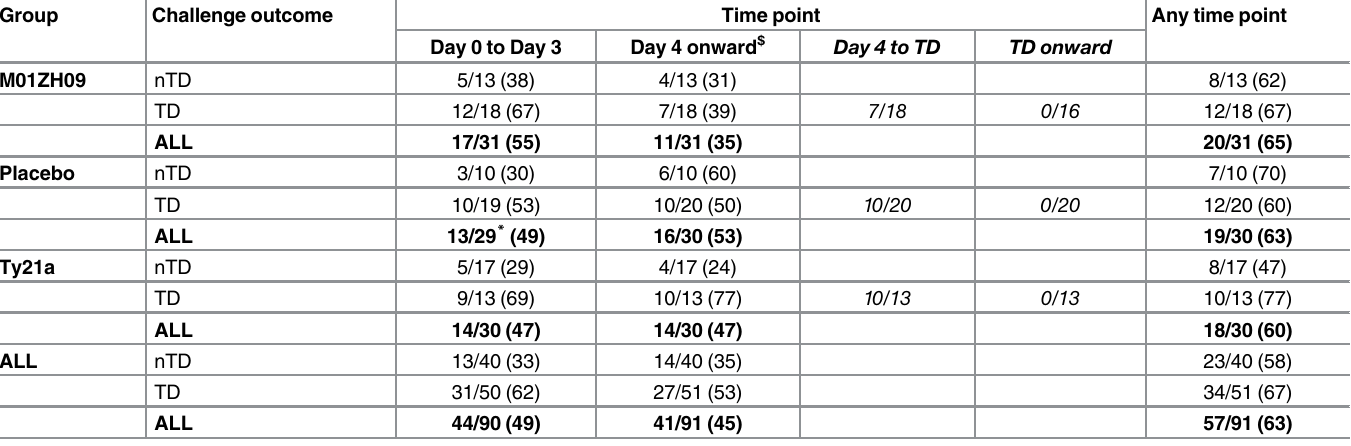
Table 4. Summary of stool shedding by participants between Day 0 (including pre-challenge) until completion of challenge, according to vaccine group allocation, challenge outcome and phase of shedding.